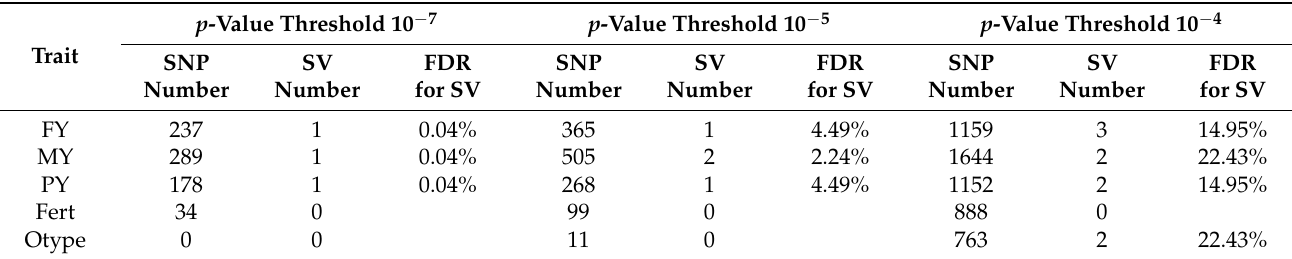
Table 1. Number of SNPs and SVs and corresponding FDR below p -value thresholds of 10 − 7 , 10 − 5 and 10 − 4 for production traits, fertility and overall type for meta-analysis of bull and cow GWAS results.